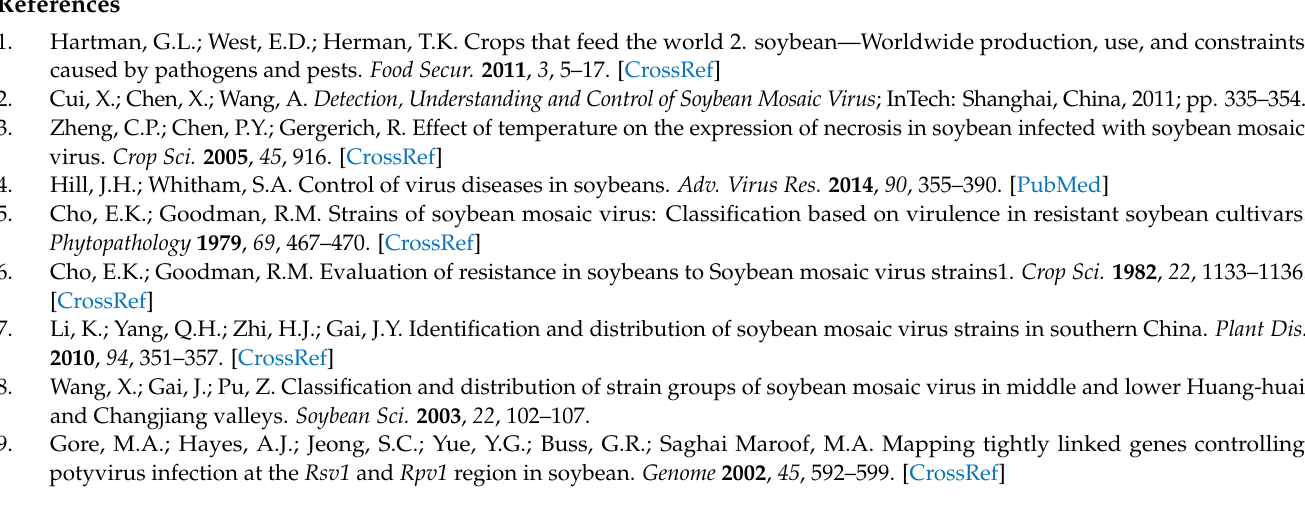
Table S5: List of gene expression levels were indicated as FPKM (R-1-0D-vs-7D); Table S6: List of gene expression levels were indicated as FPKM (R-1-0D-vs-14D); Table S7: List of gene expression levels were indicated as FPKM (S-1-0D-vs-7D); Table S8: List of gene expression levels were indicated